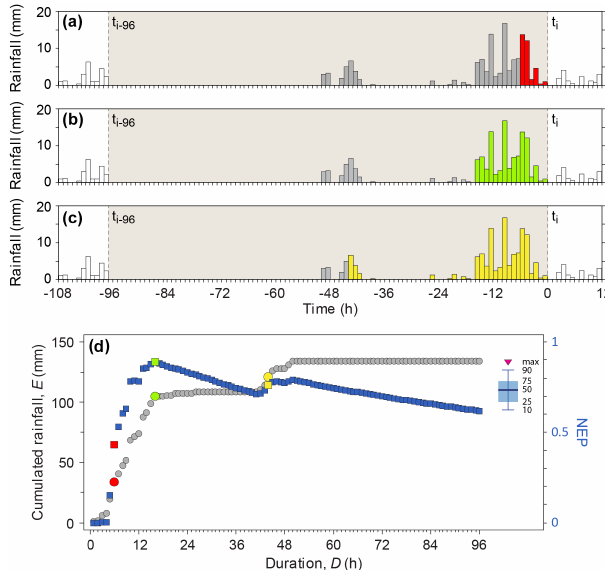
Figure 9. Exemplification of the E-NEP algorithm used to provide a non-exceedance probability (NEP) of possible landslide occurrence. Panels (a) , (b) and (c) show the same rainfall record and three an- tecedent conditions corresponding to durations of (a) D = 6h (red bars), (b) D = 16h (green bars) and (c) D = 44h (yellow bars). Panel (d) shows rainfall ( D,E) pairs (grey dots); red, green and yel- low dots represent the ( D,E) pairs corresponding to the conditions shown in (a) , (b) and (c) . Blue squares show the corresponding non- exceedance probabilities (NEP). Green square represents NEP max . See text for